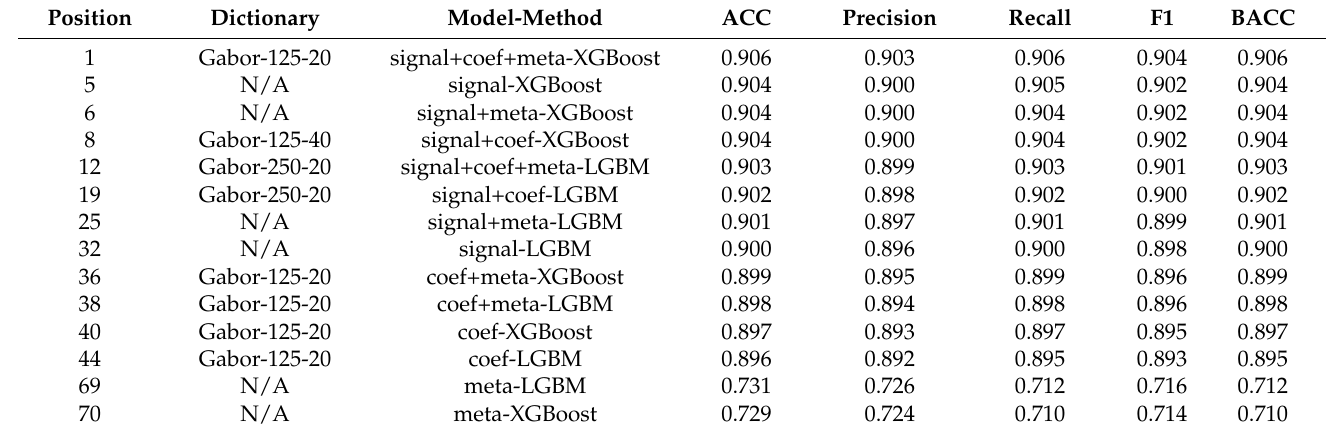
Table 6. Summary of average metrics scores for each data model, class size = 2.